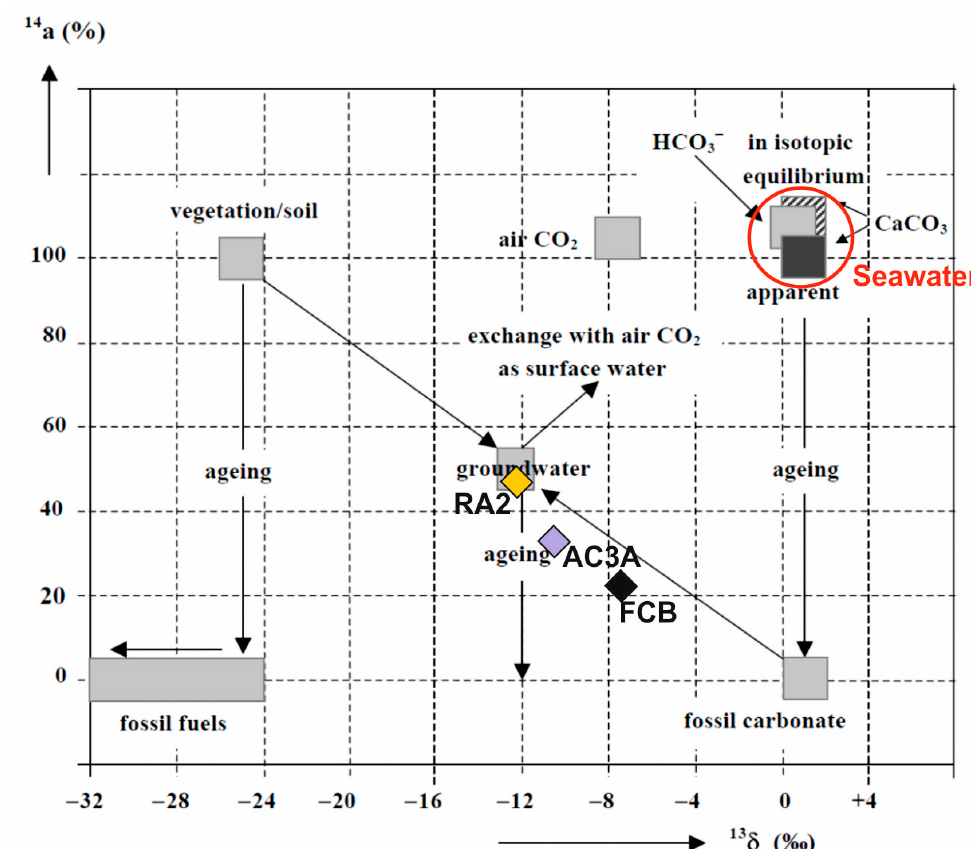
Figure 9. δ 13 C TDIC (‰ V-PDB) vs. a 14 C TDIC (pMC) diagram including isotopic values of RA2, AC3A and FCB samples, as typical seawater isotopic signature. Modified from [52]. CDR: average composition of Caldas da Rainha thermomineral waters from [27].